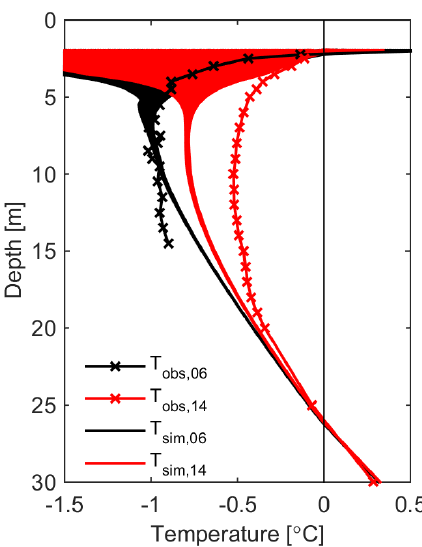
Figure 8. Comparison of observed and simulated permafrost tem- perature changes at the Chumaer site over the period from 2006 to 2014. The measured temperatures, T obs,06 and T obs,14 , were taken from a shallow borehole and a nearby deep borehole on 30 August 2006 and 22 February 2014, respectively, while the simulated ones T sim,06 and T sim,14 show all values from the corresponding